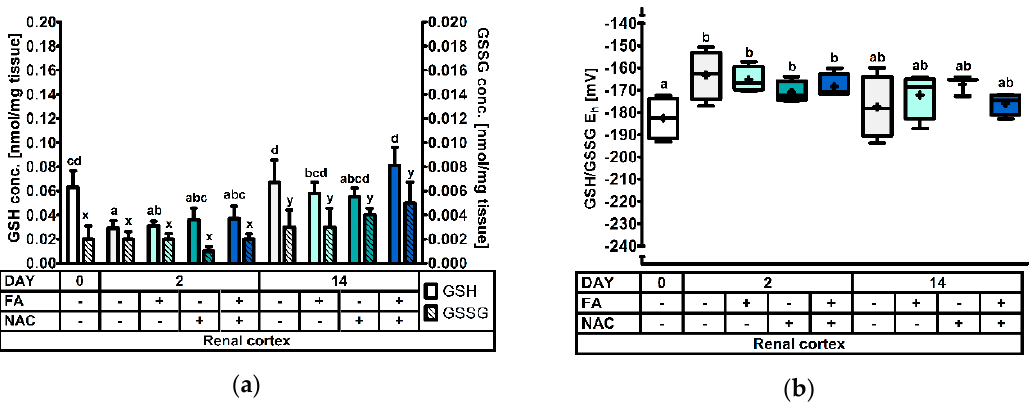
Figure 5. The glutathione redox system in kidney tissue of piglets at 0d, 2d and 14d post-weaning (DAY), either ad libitum fed (FA − ) or fasted (FA+) the first 2d post-weaning, and either provided standard drinking water (NAC − ) or water supplemented with 200 mg/L N -acetyl cysteine (NAC+) during the first 14d post-weaning. Results are presented as least squares means with SD. Significance levels of main effects and interaction terms are presented in Table 3: ( a ) Renal cortical glutathione (GSH) and glutathione disulphide (GSSG) concentrations. a,b,c,d and x,y respectively represent differences in GSH or GSSG concentrations between treatments ( p ≤ 0.05); ( b ) Renal cortical glutathione redox status (GSH/GSSG E h ). a,b represent the effect of DAY across other factors ( p ≤ 0.05).